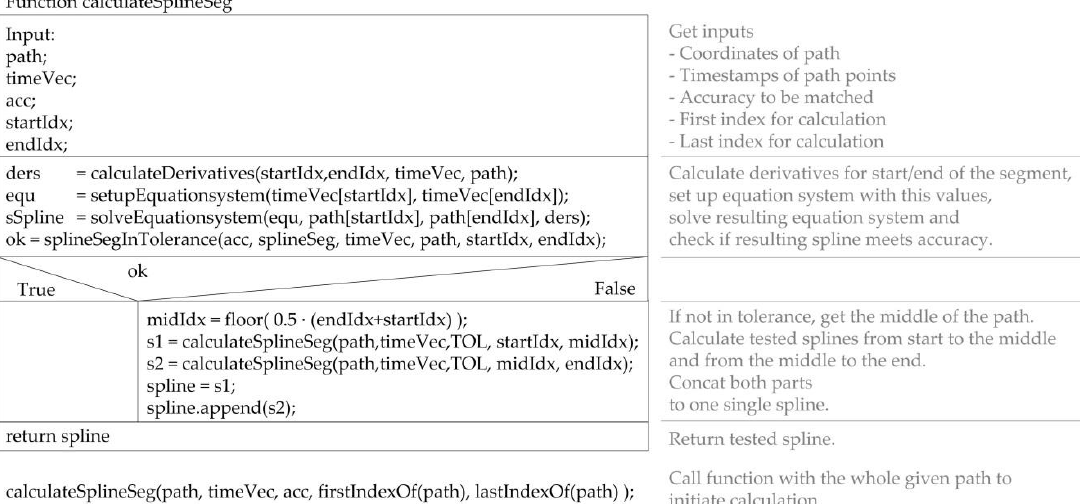
Figure 6. Monomial spline-based recursive algorithm msRECUR.